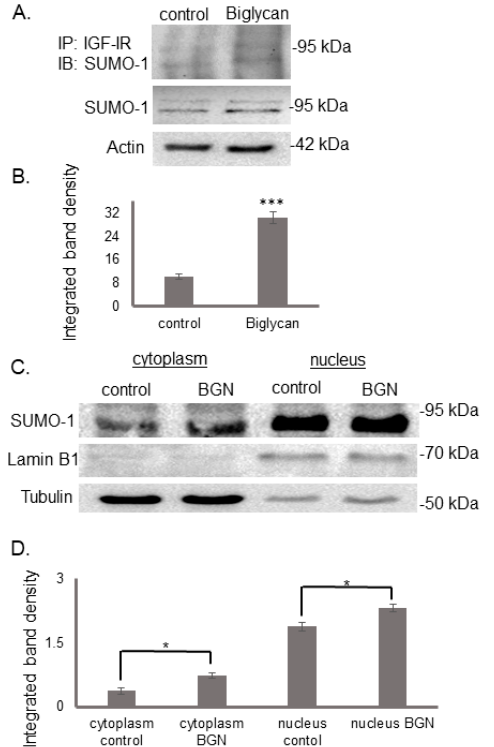
Figure 6. Effect of biglycan on colocalization of IGF-IR with SUMO-1 and SUMO-1 deposition in the cell. Control cells were treated with serum-free culture medium, and samples were treated for 48 with biglycan (10 μ g/mL). ( A ) Cells extracts were incubated with IGF-IR antibody overnight in a rotating platform and IGF-IR complexes were immunoprecipitated with Protein A/G. Western blot analysis was used for the visualization of SUMO-1 protein immunoprecipitation with IGF-IR. ( B ) Densitometric analysis of the bands of immunoprecipitated proteins was normalized against the total expression of each protein in the cells and plotted. ( C ) Expression of SUMO-1 in the cytoplasmic compartment of the cells treated with 0% FBS-medium (cytoplasm control) and cells treated with biglycan 10 μ g/mL (cytoplasm BGN), as well as the nuclear compartment of the cells (nucleus control; nucleus BGN) were determined by Western blot analysis. Purity controls tubulin and lamin B1 were used for cytoplasmic and nuclear proteins, respectively. Equal amounts of protein from each compartment were loaded, and ( D ) densitometric analysis was performed and plotted. Representative blots are presented. Results represent the average of three separate experiments. Means ± S.E.M were plotted; statistical significance: * p ≤ 0.05, *** p ≤ 0.001 compared with the respective control samples.